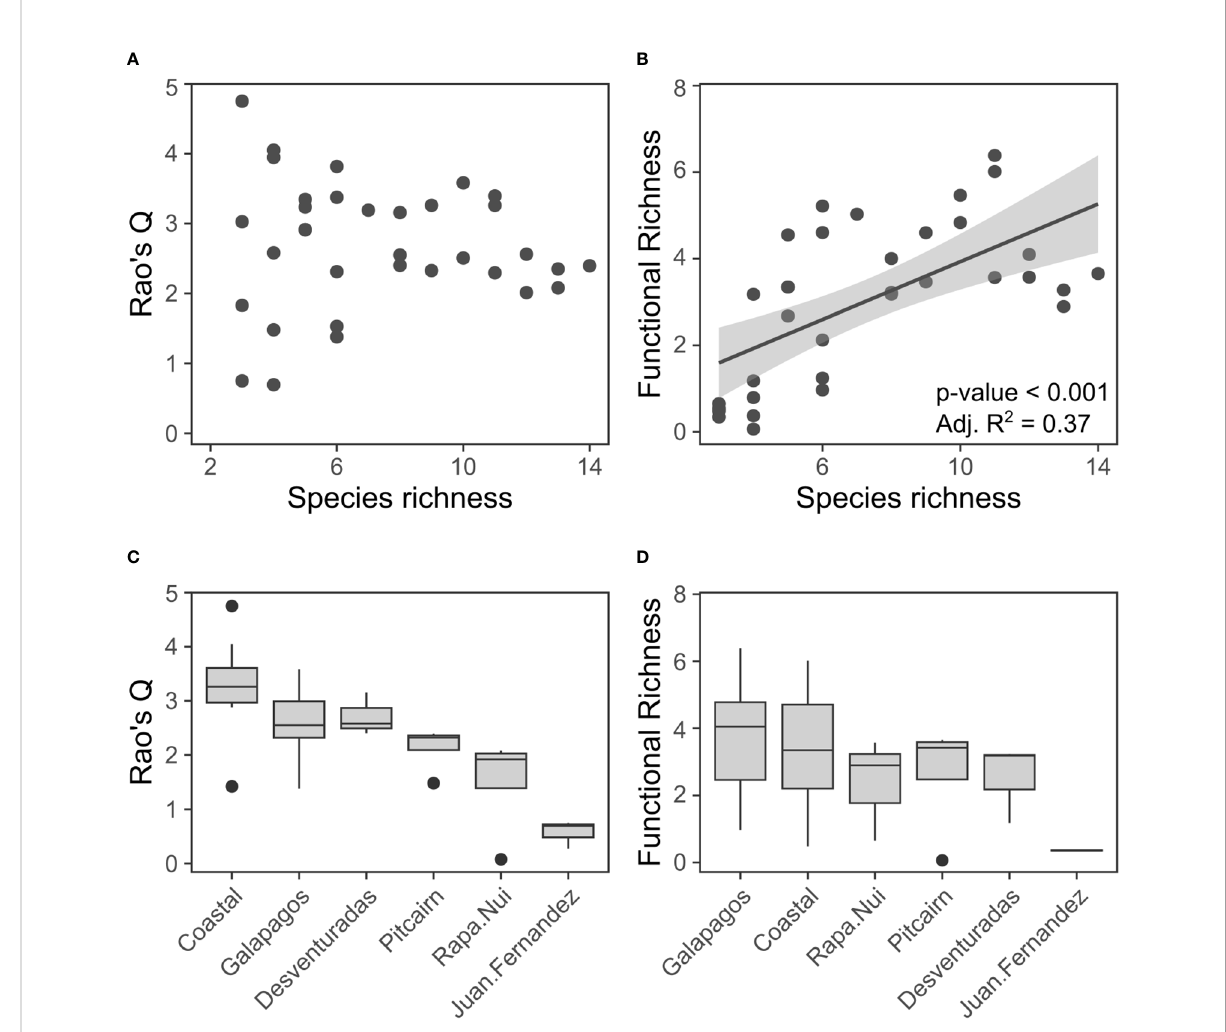
FIGURE 2 Changes in trait diversity of seabird assemblages across islands of the southeastern Paci fi c. Relationship between species richness and (A) Rao ’ s Q, and (B) FRic. The linear fi t (black line), its associated 95% CI (gray area), and respective-value and adjusted R 2 are shown for the signi fi cant fi t for the FRic model. Boxplots depicting changes in trait diversity across archipelagos for (A) Rao ’ s Q, and (B) FRic. Midlines represent medians, boxes represent the interquartile range between quartiles 1 and 3, whiskers represent minimum and maximum non-outlier values, and dots represent